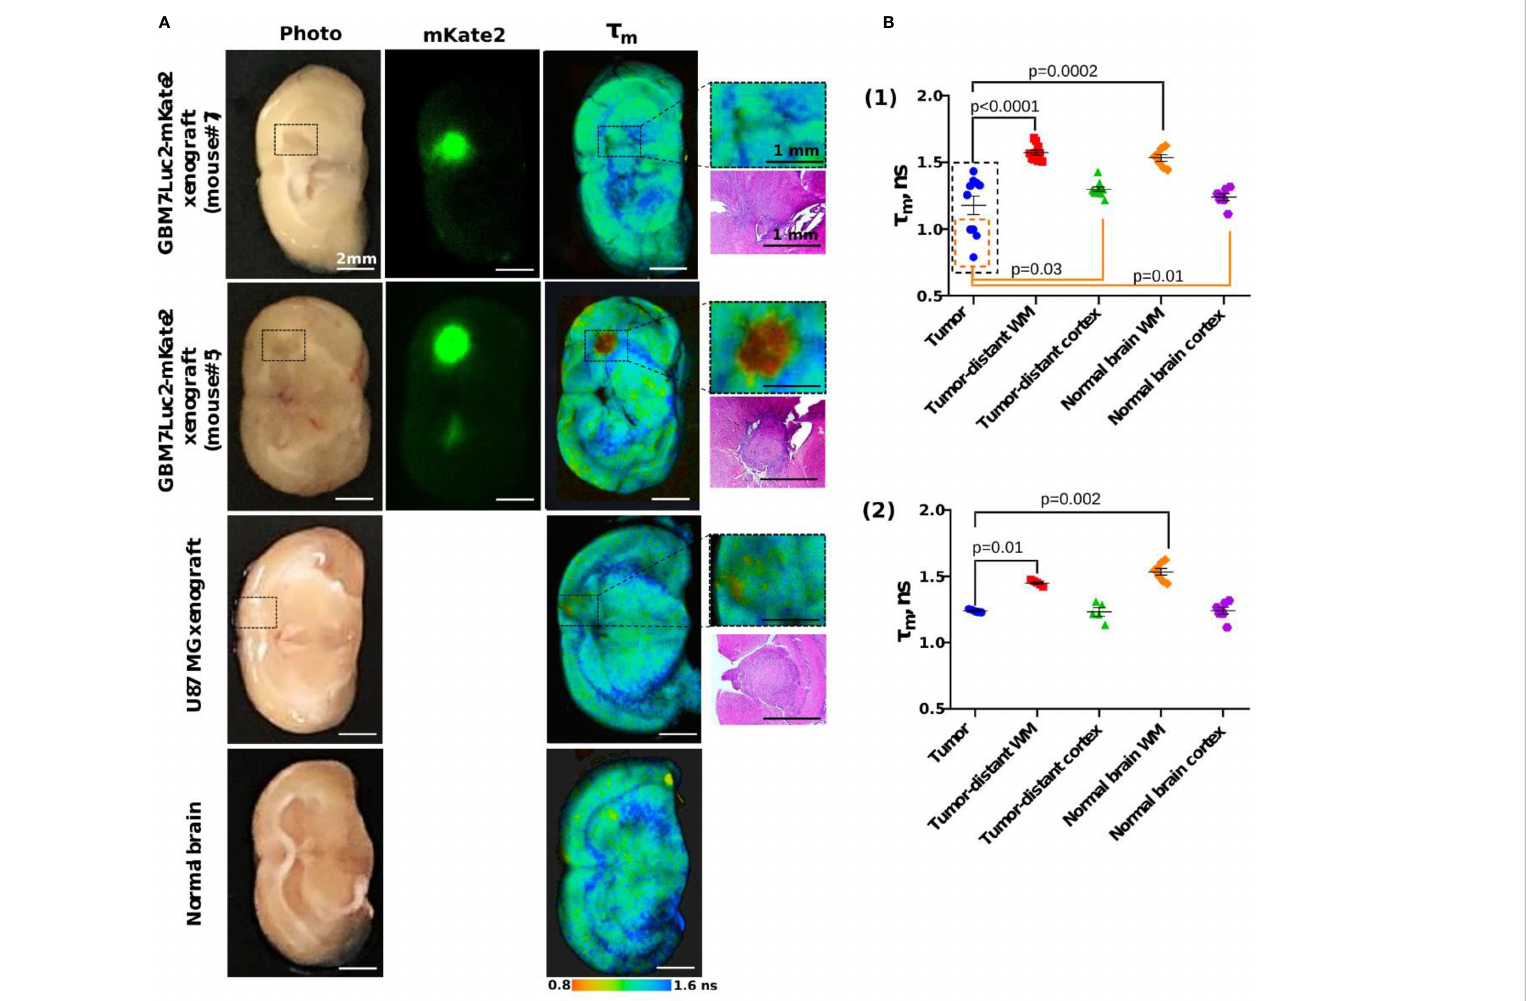
FIGURE 7 Macro-FLIM of human GBM xenografts and normal brain. (A) Representative auto fl uorescence time-resolved images of GBM7-Luc2-mKate2 xenografts, U87 MG xenograft and normal mouse brain without tumor. Enlarged regions with a tumor are indicated by the black squares on the lower-magni fi cation panel. Corresponding H&E stained section is presented under each enlarged region. (B) Quanti fi cation of the mean fl uorescence lifetime tm in NAD(P)H spectral channel in (1) dual-labeled human GBM xenografts and (2) U87 MG xenografts and normal brain. Scatter dot plot displays the measurements for individual animals (dots) and the mean and SEM (horizontal lines). WM is a white